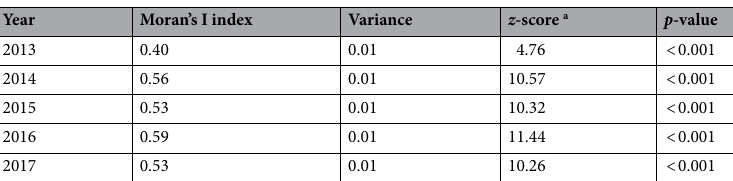
Table 3. Spatial autocorrelation of vision impairment (VI) among children in Shandong province from 2013– 2017. a | z |> 2.58 indicates that the probability of randomly generating this clustering pattern is less than 1%.